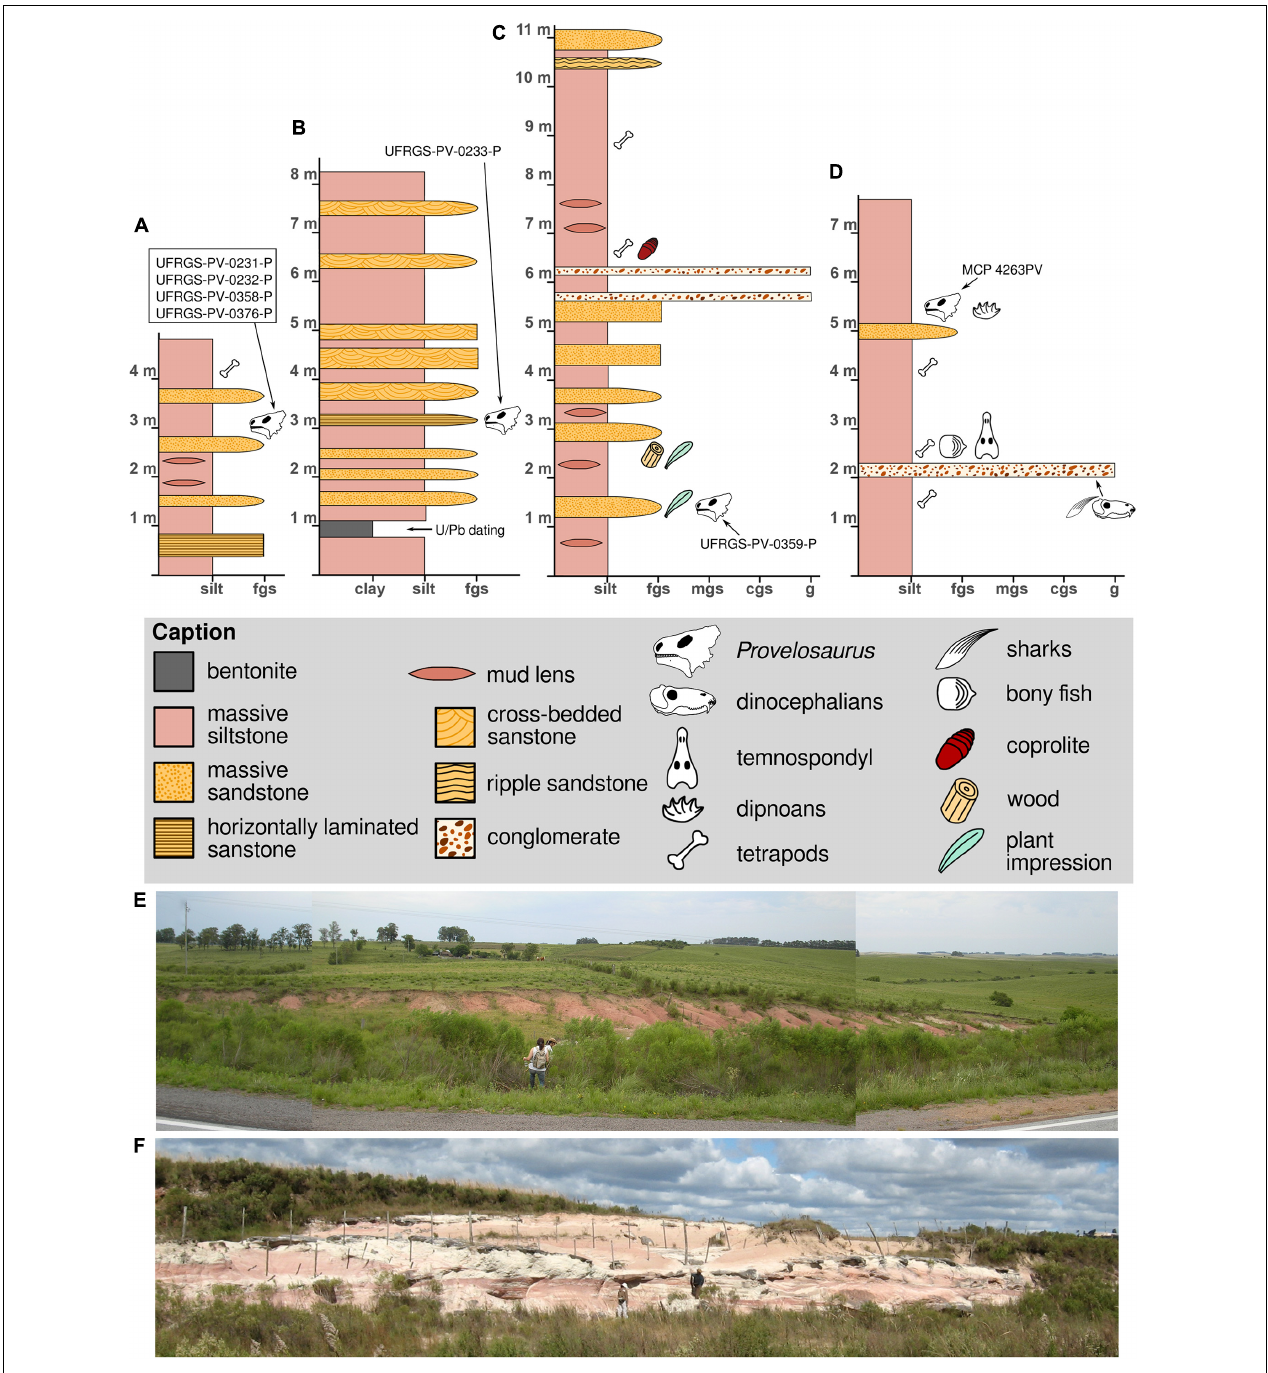
FIGURE 2 | Stratigraphic logs (A–D) and general view (E,F) of the exposures that produced pareiasaur remains, see Figure 1 for locations. (A,E) Type locality of Provelosaurus americanus , photograph taken in 2009, the locality is now largely covered by vegetation; (B,F) exposure at km 666, with a bentonite layer U-Pb dated 266.7 ± 5.4 Ma (Rocha-Campos et al., 2019); (C) Santo Antônio Farm outcrop; (D) Fagundes site stratigraphic